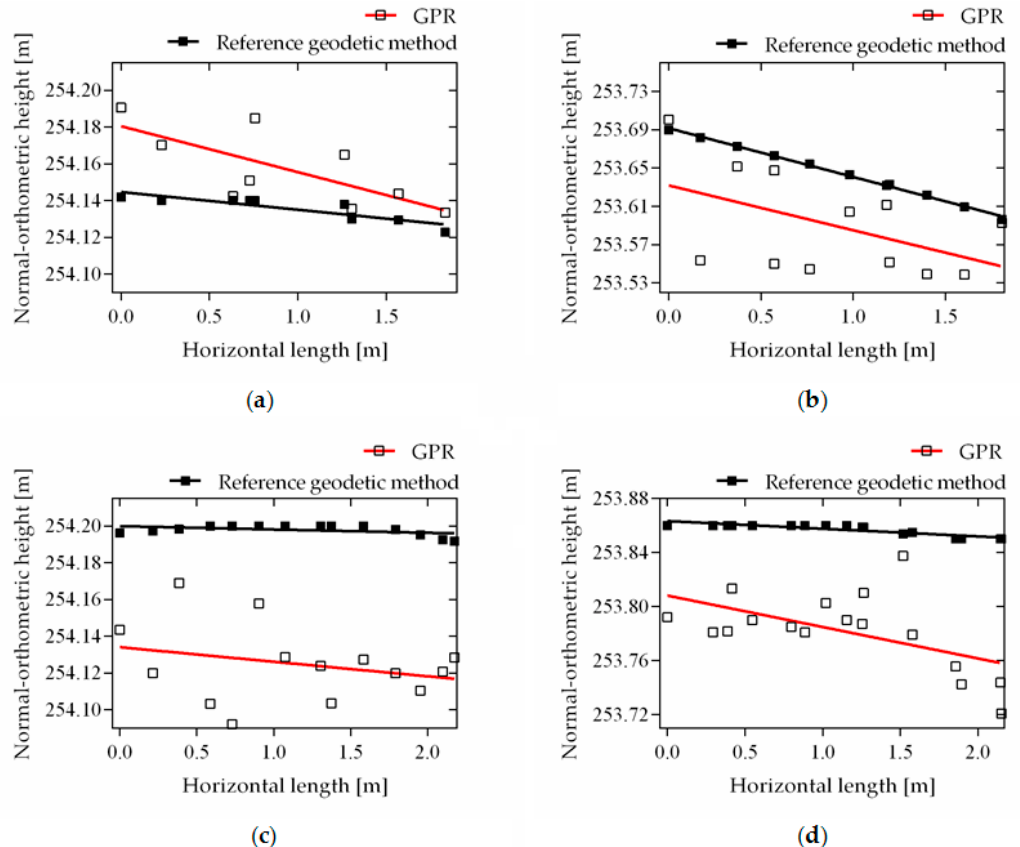
Figure 19. Presentation of inclinations of reference (black line) and proposed GPR-TPS model (red line). ( a ) black line: − 0.9% inclination, r 2 = 0.78, red line: − 2.5% inclination, r 2 = 0.52 of target object No. 1 ( RMSE ∆ h = 0.078 m, µ ∆ h = 0.015 m, σ ∆ h = 0.081 m); ( b ) black line: − 5.1% inclination, r 2 = 0.99, red line: − 4.7% inclination, r 2 = 0.25 of target object No. 10 ( RMSE ∆ h = 0.082 m, µ ∆ h = 0.031 m, σ ∆ = 0.079 m); ( c ) black line: − 0.18% inclination, r 2 = 0.20, red line: − 0.79% inclination, r 2 = 0.08 h of target object No. 2 ( RMSE ∆ h = 0.090 m, µ ∆ h = 0.047 m, σ ∆ h = 0.079 m); ( d ) black line: –0.5% inclination, r 2 = 0.77, red line: − 2.3% inclination, r 2 = 0.29 of target object No. 7 ( RMSE ∆ h = 0.053 m, µ ∆ = 0.045 m, σ ∆ = 0.028 h h